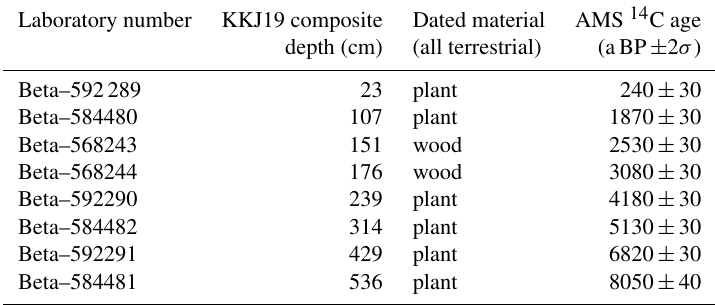
Table 2. Radiocarbon ( 14 C) ages of terrestrial plant macrofossils from composite profile KKJ19 with sediment